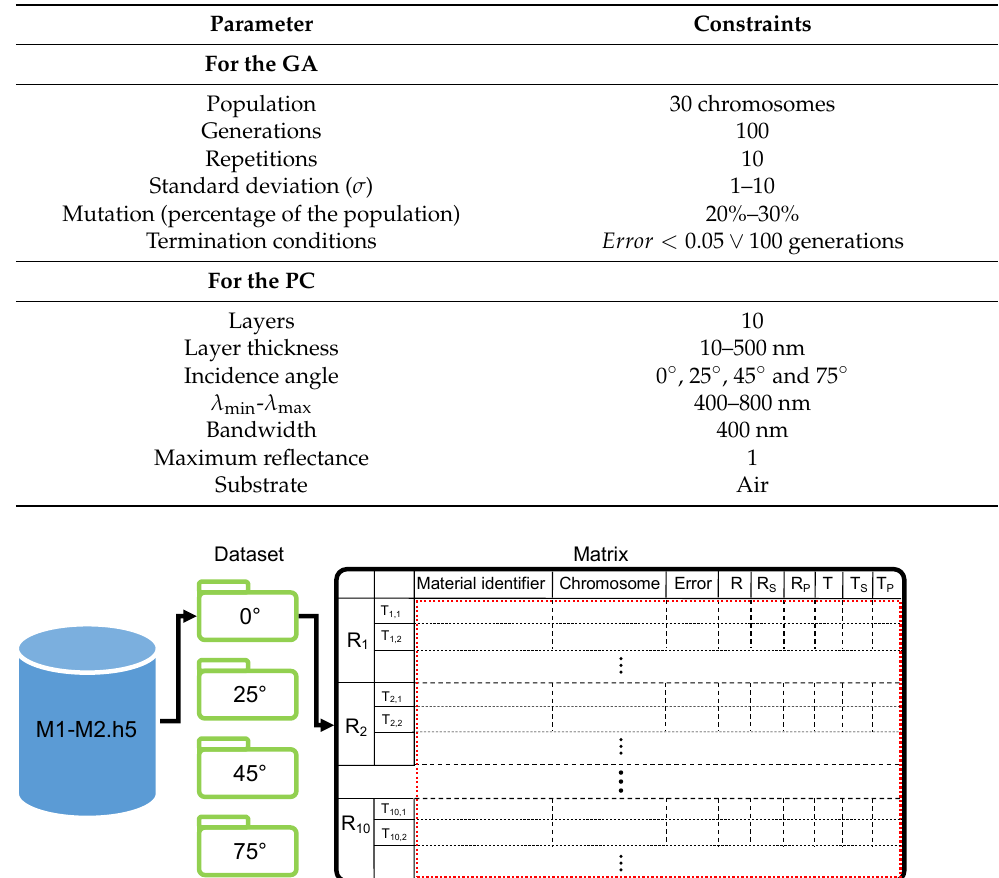
Table 2. Parameters used in the GA for the database generation.